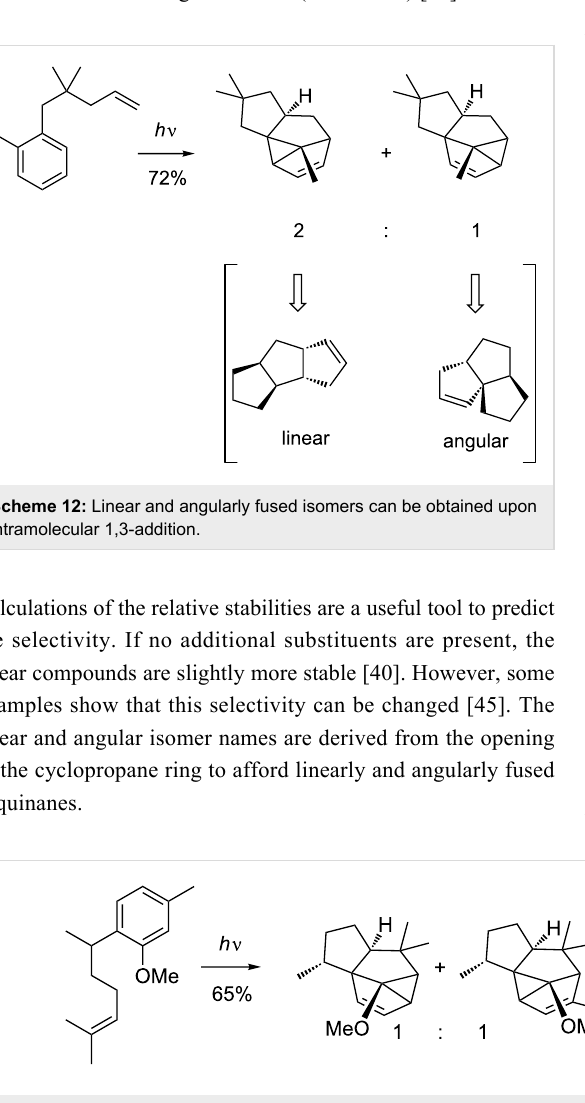
Scheme 13: Synthesis of α -cedrene via diastereoselective meta photocycloaddition.